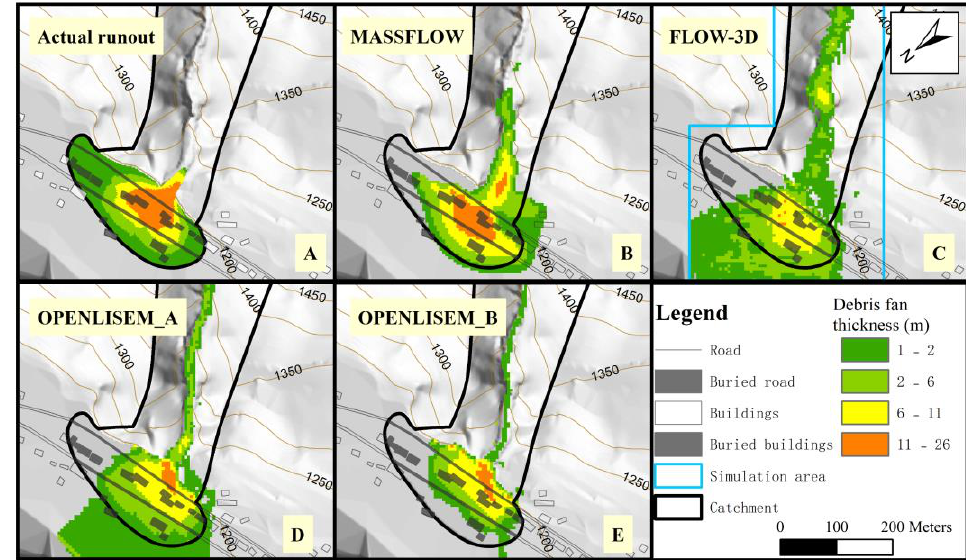
Figure 7. Debris flow fan in 2013: Actual runout ( A ) and best simulations by Massflow ( B ), Flow-3D ( C ), OpenLISEM_A ( D ), OpenLISEM_B ( E ). The full sets of model parameters are given in Table 1.